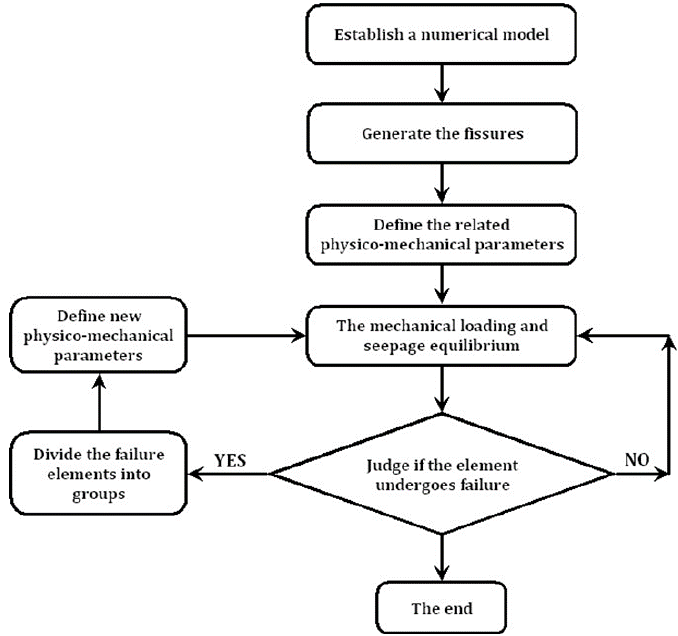
Figure 2. The procedure for the implementation of the elastic-brittle coupling model in Lagrangian analysis of continua